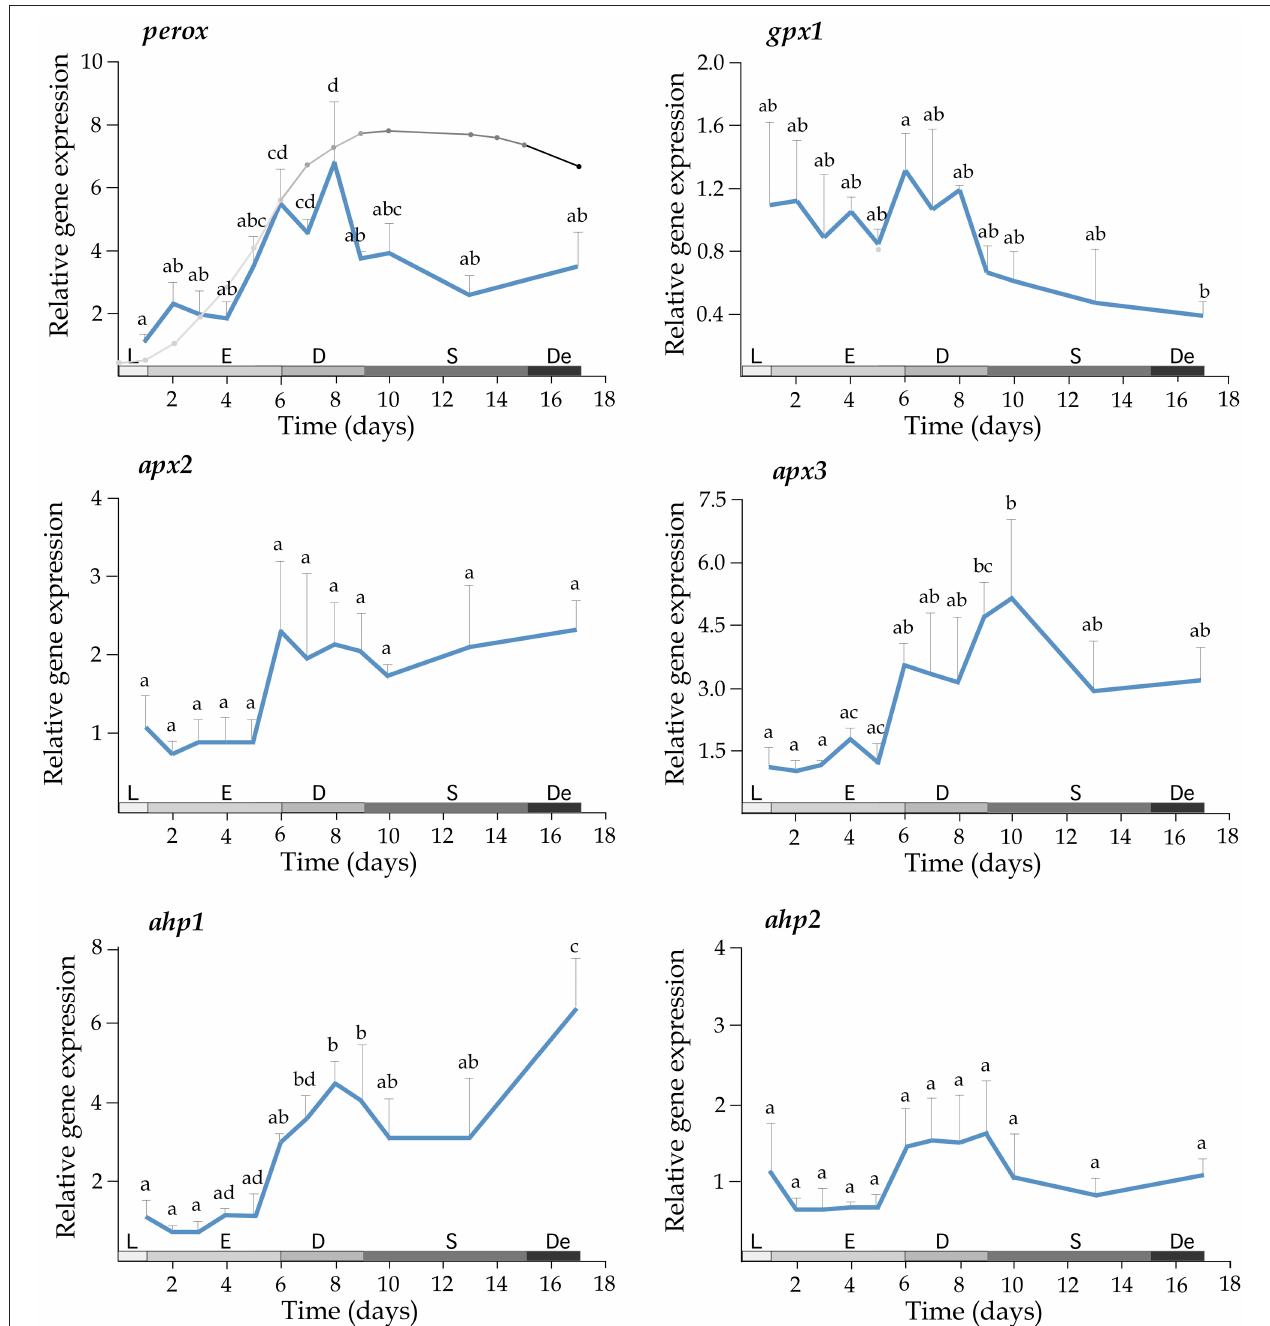
FIGURE 3 | Expression profiles of perox , gpx1 , apx2 , apx3 , ahp1, and ahp2 during the growth of T. lutea . Data represent the mean ± SEM. Data were normalized using ubi and calibrated to 1 day of culture. Different letters denote statistically significant differences between sampling times after the post-hoc test. The growth stages including lag phase (L), exponential phase (E), retardation phase (D), stationary phase (S), and declining phase (De) are shown below.